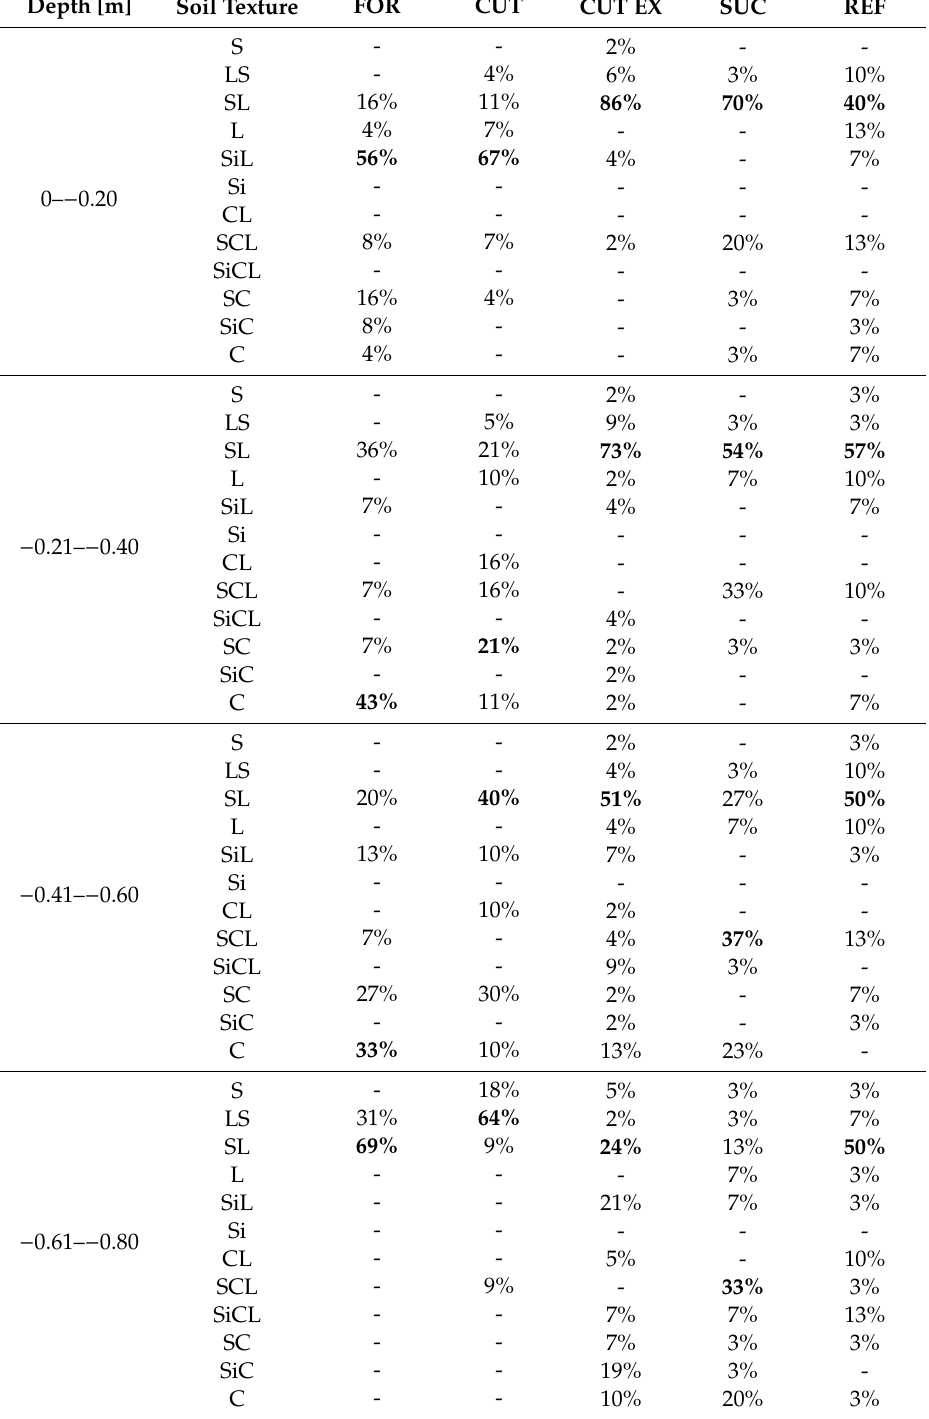
Table 3. Soil texture percentages for depth-aggregated data, soil textures according to FAO WRB. Highest percentages indicated